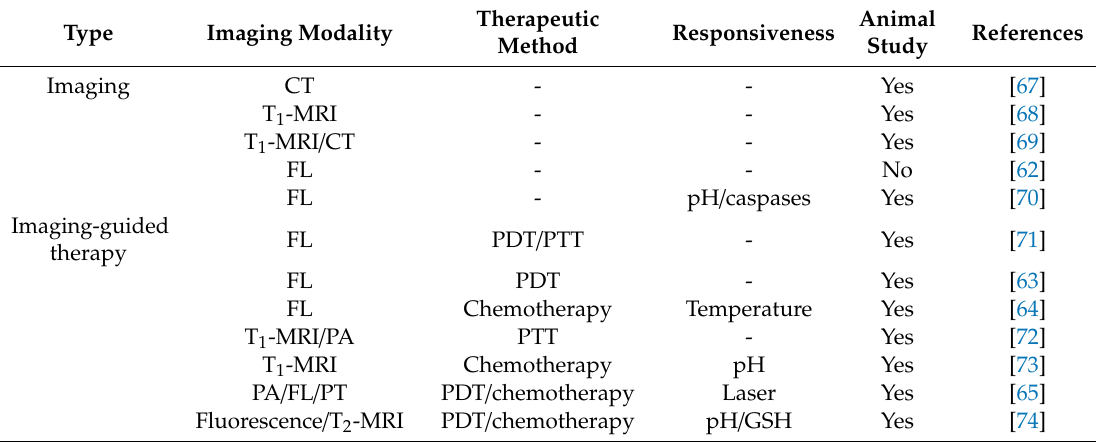
Table 3. Summary of the nanogels for cancer imaging and imaging-guided therapy by imaging modality, therapeutic method, responsiveness and animal